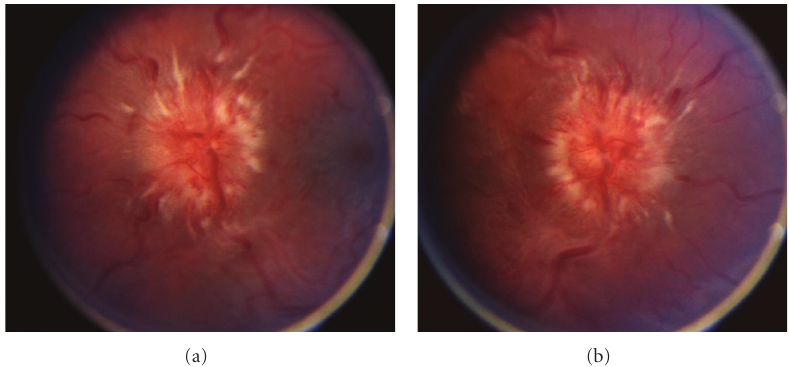
Figure 2: Optic disc appearance, case 2. Fundoscopy of the left eye (a) and right eye (b) reveals grade IV papilledema as evidenced by severe elevation and